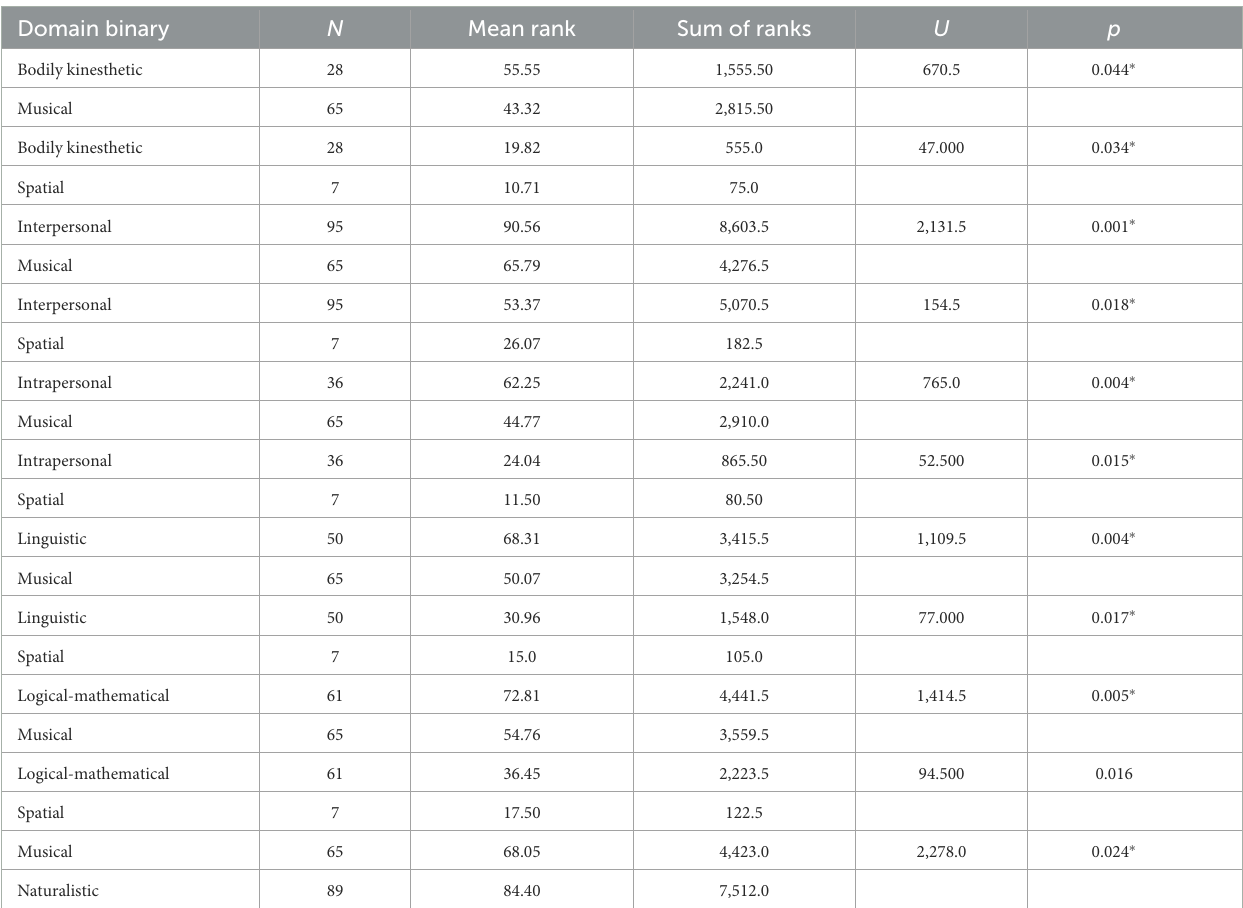
TABLE 6 Pairwise comparisons of the critical thinking and problem solving subscale scores of university students obtained from the twenty-first-century skills scale by the self-perceived intelligence types. Domain binary N Mean rank Sum of